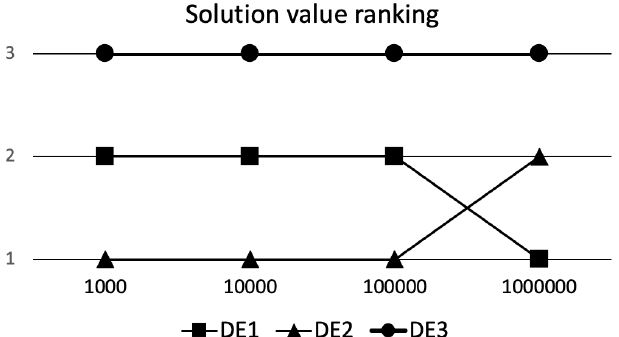
Figure 2. Deep Statistical Comparison (DSC) ranking.